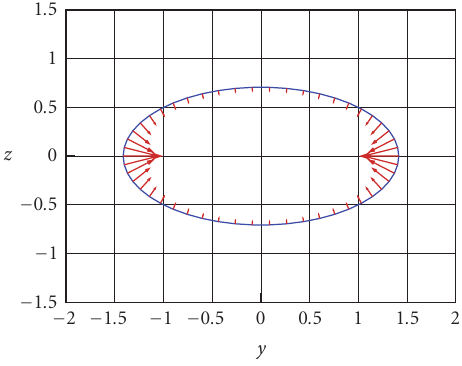
Figure 6.5. Normal stress ( T nn n y + T nn n z ) / 50dyn/cm 2 for an ellipse y 2 /b 2 + z 2 /c 2 = 1 − 1 . 0 2 /a 2 at x = − 1 . 0 cm in the ( y , z )-plane. Perpendicular view of the cross section (d) in Figure 6.1. Small com- pression at the center and high compression at the right and left poles of the ellipse (indicated by small and big inwards arrows). This suggests that the upper part of a gas bubble rising in a viscoelastic fluid would tend to be